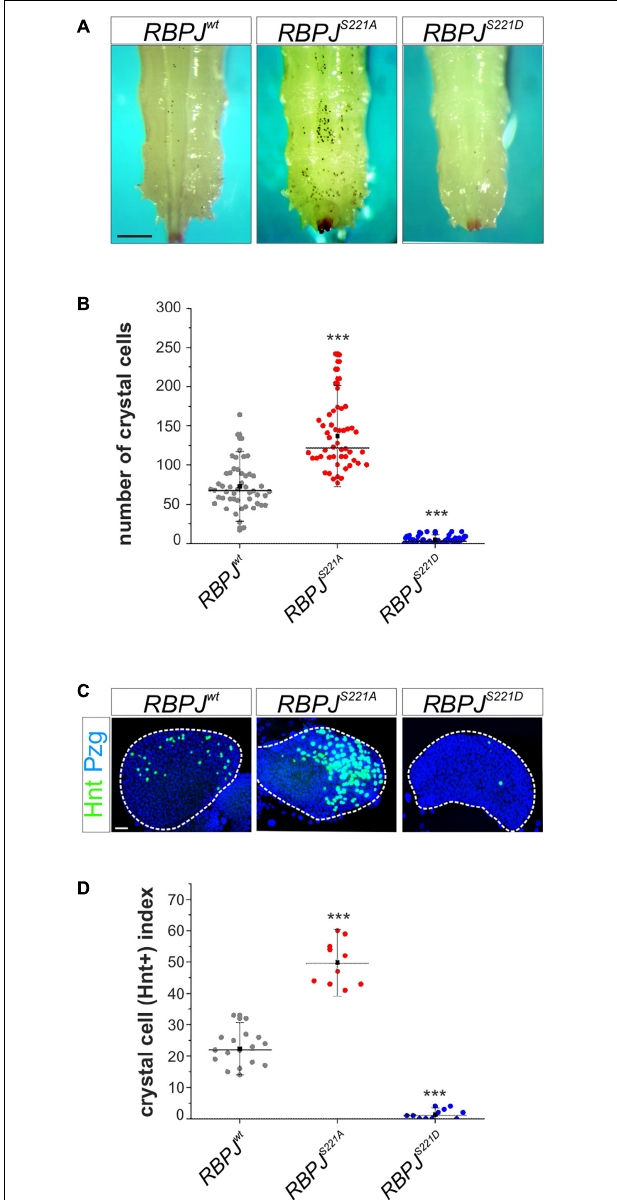
FIGURE 6 | Drosophila crystal cell development is impeded in a murinized fly model. (A) Crystal cells, visualized by heating RBPJ wt , RBPJ S 221 A , and RBPJ S 221 D homozygous larvae. Scale bar represents 250 µ m for all panels. (B) Quantification of melanized crystal cells within the last two segments of the given genotype ( n = 50). RBPJ S 221 A had more, whereas RBPJ S 221 D larvae had reduced numbers of sessile crystal cells. Individual data points are indicated; mean is shown as a black square, the median as horizontal bar. Error bars represent ± s.d. *** p < 0.001; ns (not significant) p > 0.05, two-tailed Dunnett’s test relative to control. (C) Lymph glands from synchronized third instar larvae were stained with anti-Hnt (green) and anti-Pzg (blue) to detect mature crystal cells in the primary lobes (encircled by white dashed line). Scale bar represents 20 µ m for all panels. (D) Crystal cell indices (number of Hnt positive cells relative to primary lobe size); individual data points are indicated. Mean is shown as a black square, the median as horizontal bar. Error bars represent ± s.d. *** p < 0.001. RBPJ wt ( n = 17), RBPJ S 221 A ( n = 9), RBPJ S 221 D ( n =